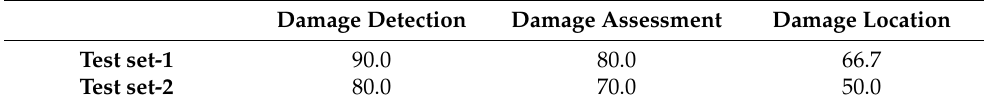
Table 7. Damage detection, assessment, and location identification tasks accuracy (%) for TFB Building.